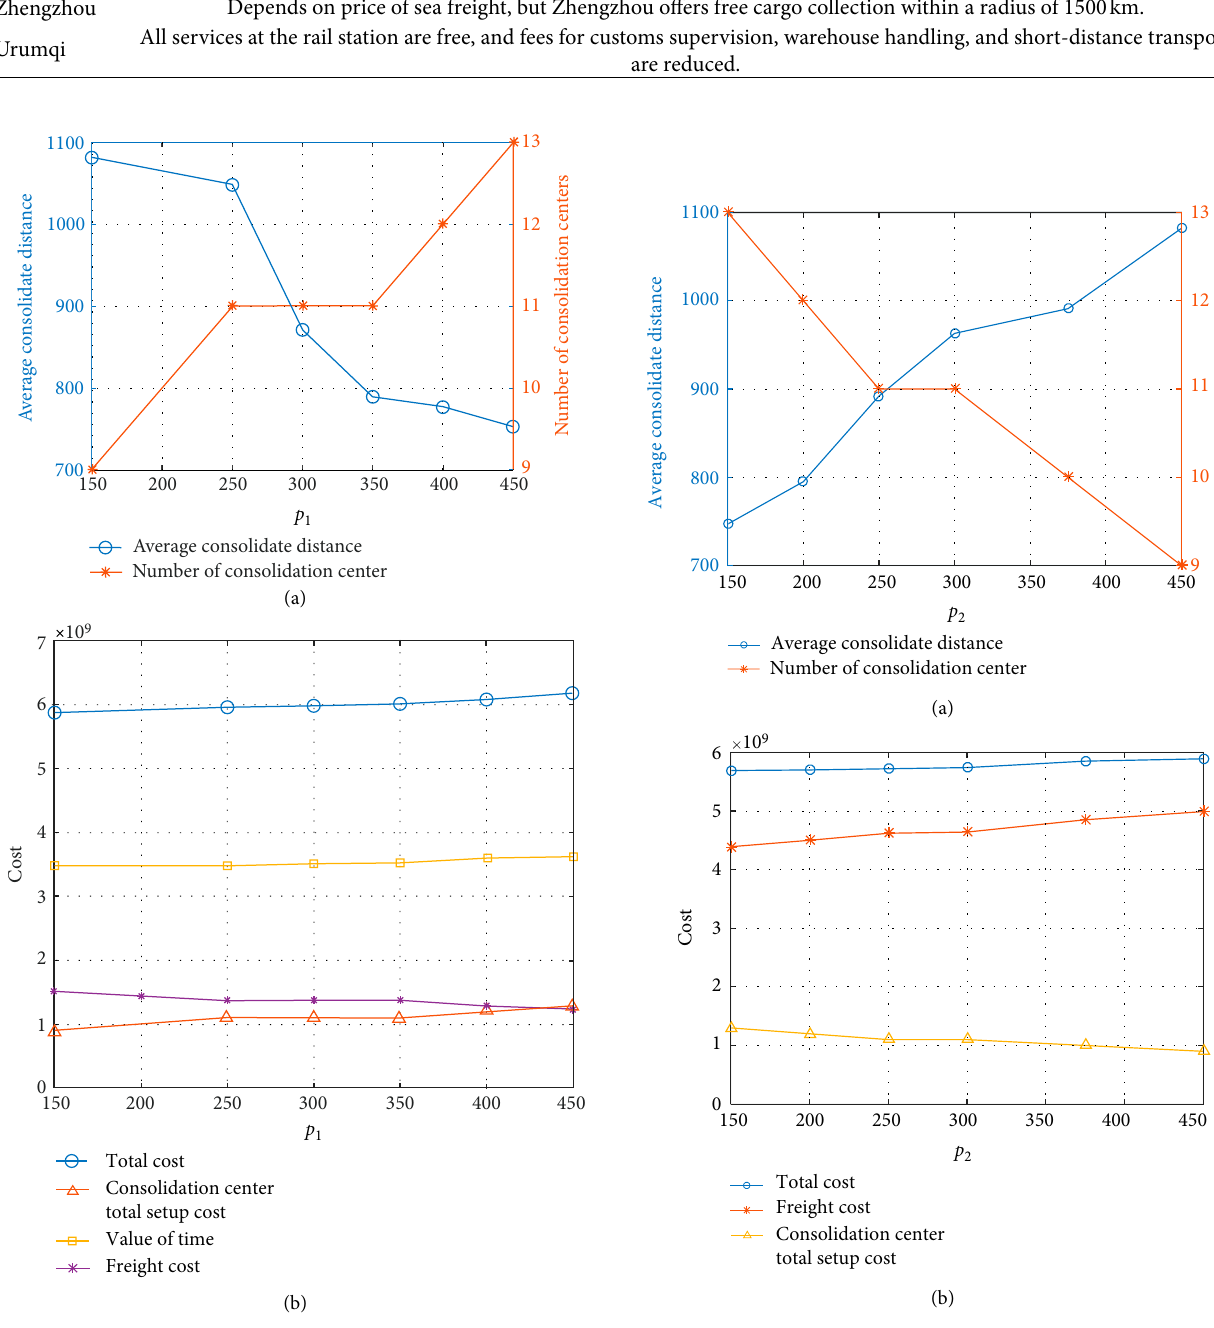
) on (a) Figure 13: Impacts of freight cost after consolidation ( 𝑝 1 the average consolidation distance and number of consolidations TC ), freight cost, and consolidation centers and (b) the total cost ( center setup